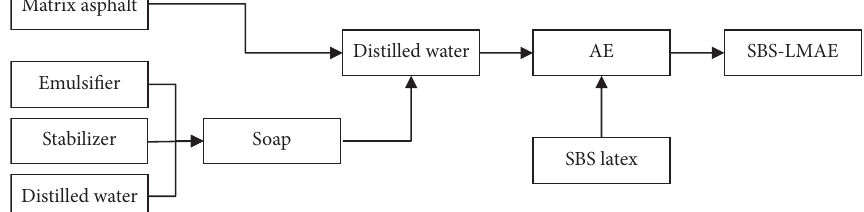
Figure 2: Preparation flowchart of